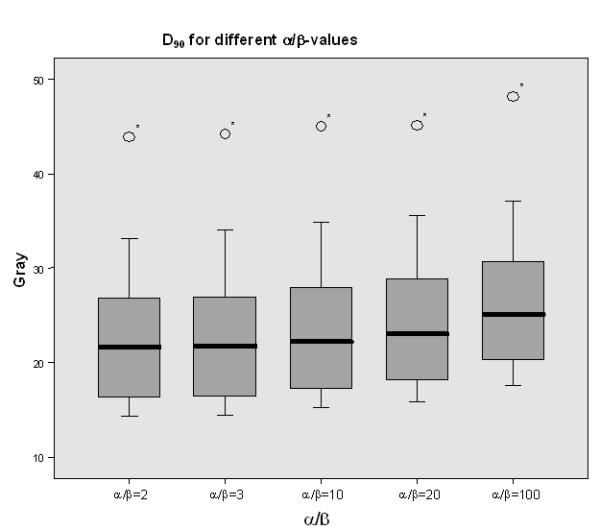
Mean D90 for different α/β-values (2, 3, 10, 20, 100) of all patients. Statistically there was a significant difference in the D90 results but the differences for clinical α/β-values were less than 1 Gy and therefore of no clinical. The star (*) represents one outlier in the series of calculation.